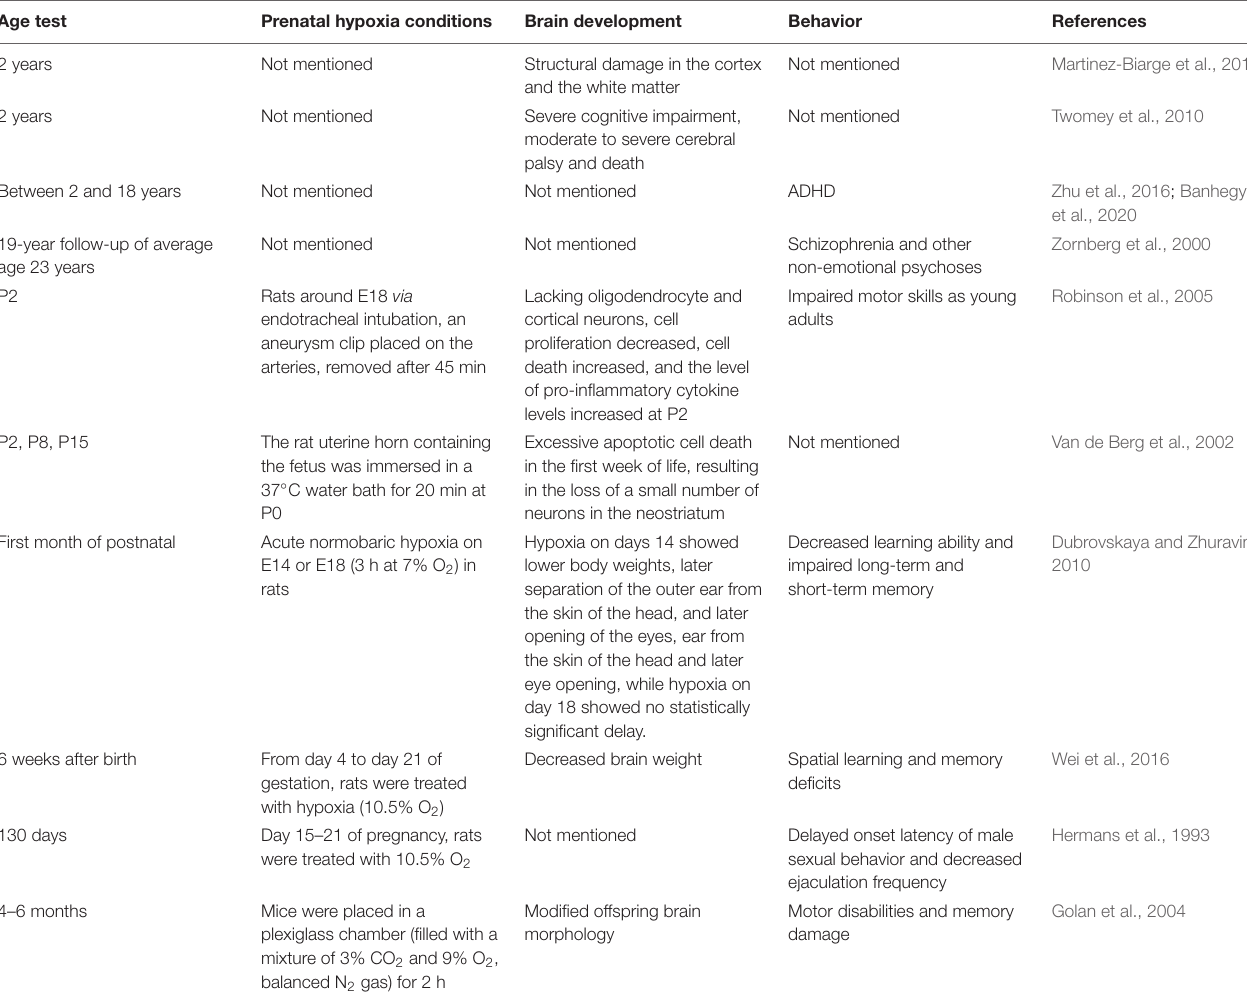
TABLE 2 | Prenatal hypoxia affects brain function in long